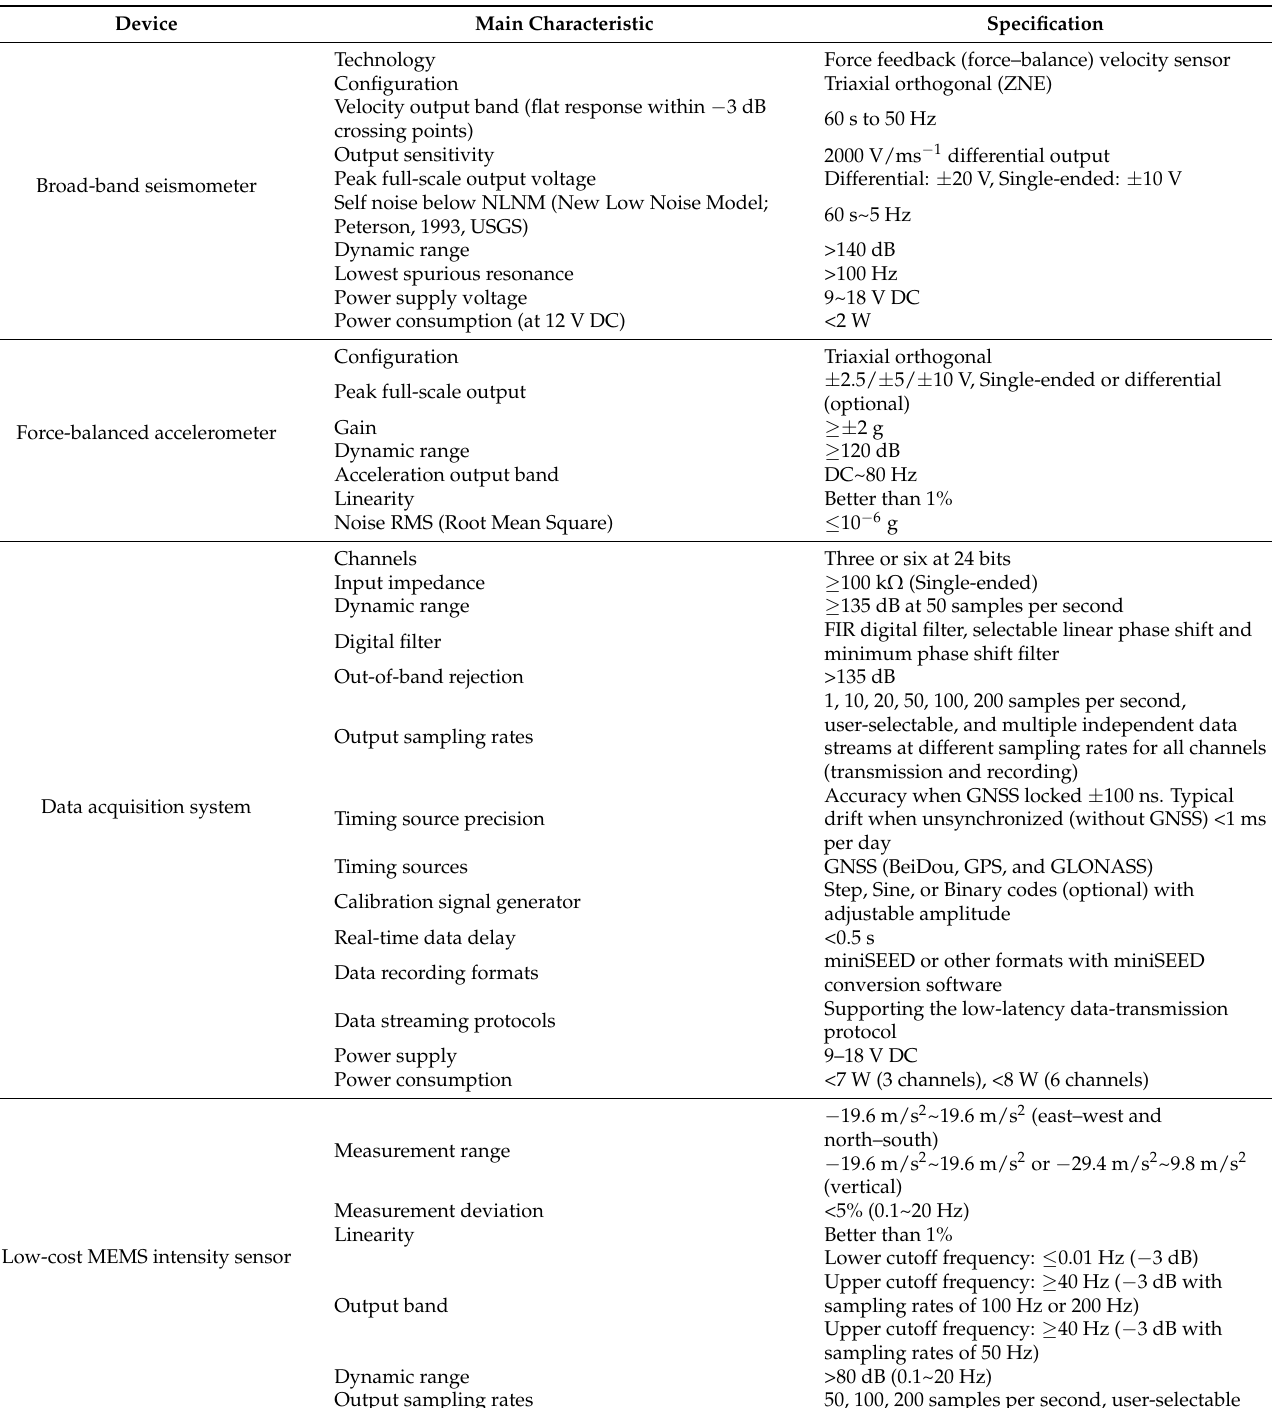
Table 1. Main characteristics of the sensors and data acquisition systems used in the Chinese national EEWS